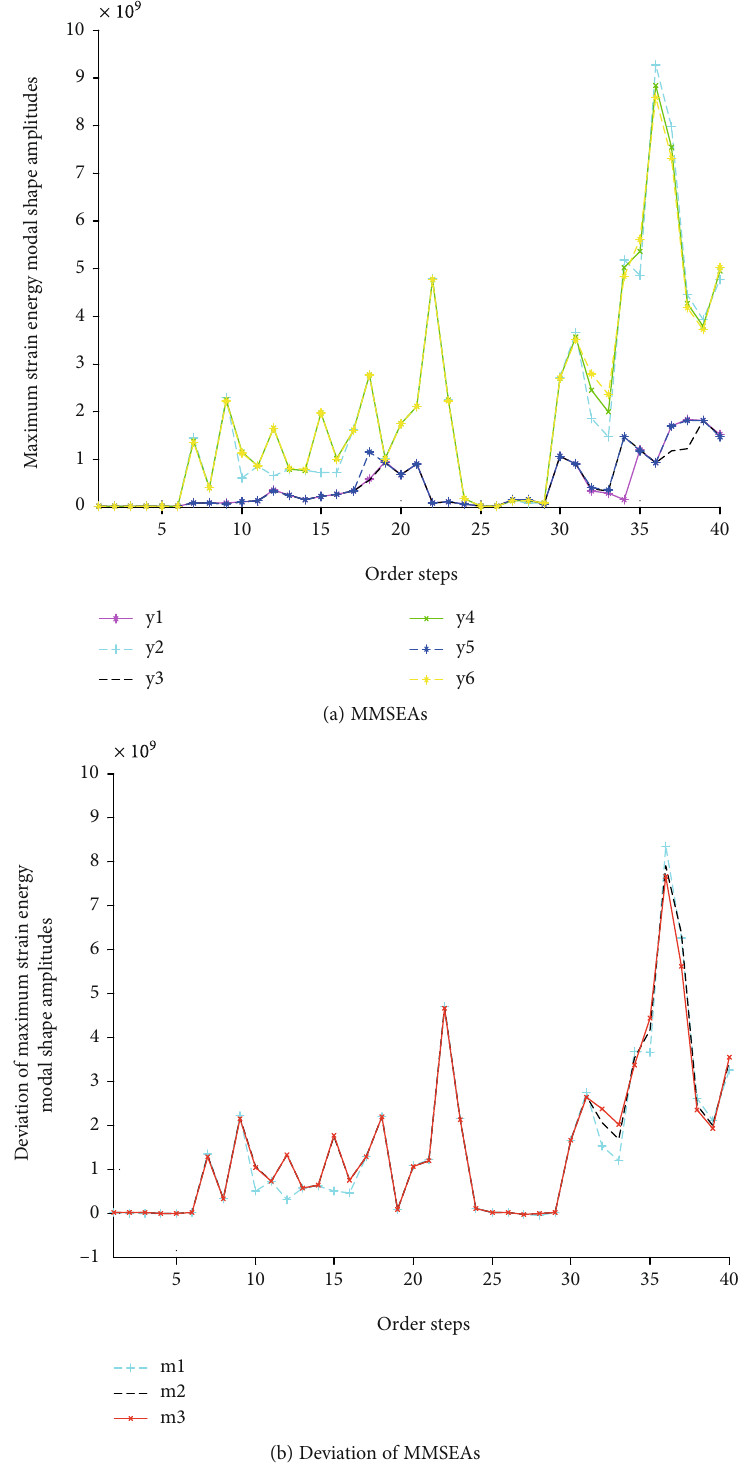
(b) Deviation of MMSEAs Figure 8: Maximum modal strain energy amplitudes analysis in di ff erent rotational speeds. (a) MMSEAs: tuned blisk: y1: w = 800rad · s − 1 ; y3: w = 1046rad · s − 1 ; y5: w = 1147 rad · s − 1 . Mistuned blisk: y2: w = 800 rad · s − 1 ; y4: w = 1046 rad · s − 1 ; y6: w = 1147rad · s − 1 . (b) Deviations of MMSEAs: mistuned blisk relative to tuned blisk: m1: w = 800rad · s − 1 ; m2: w = 1046 rad · s − 1 ; m3: w = 1147rad · s − 1